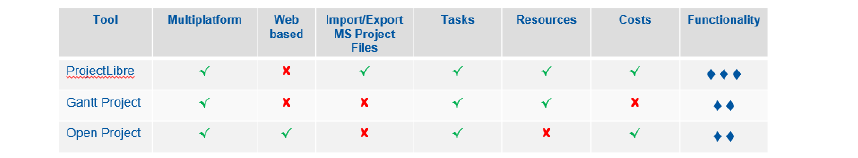
Figure 6. Market Analysis - Assessment Table for three of the shortlisted applications